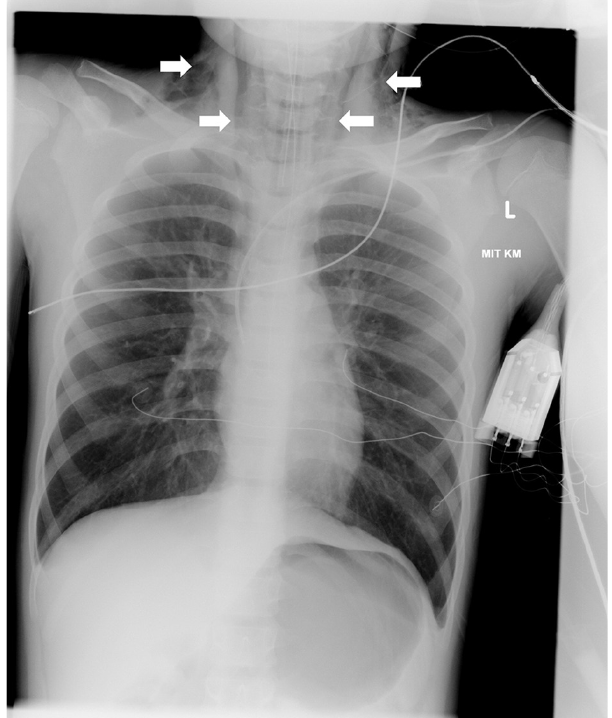
Figure 1. Chest X-ray showing hyperinflated lungs and a discrete subcutaneous emphysema at the neck and the upper mediastinum